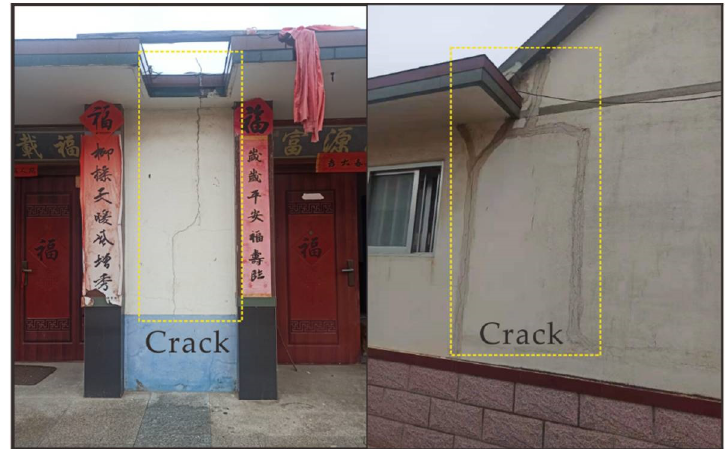
Figure 15 . Construction damages due to the mining subsidence (the yellow dashed box shows the position of the cracks).